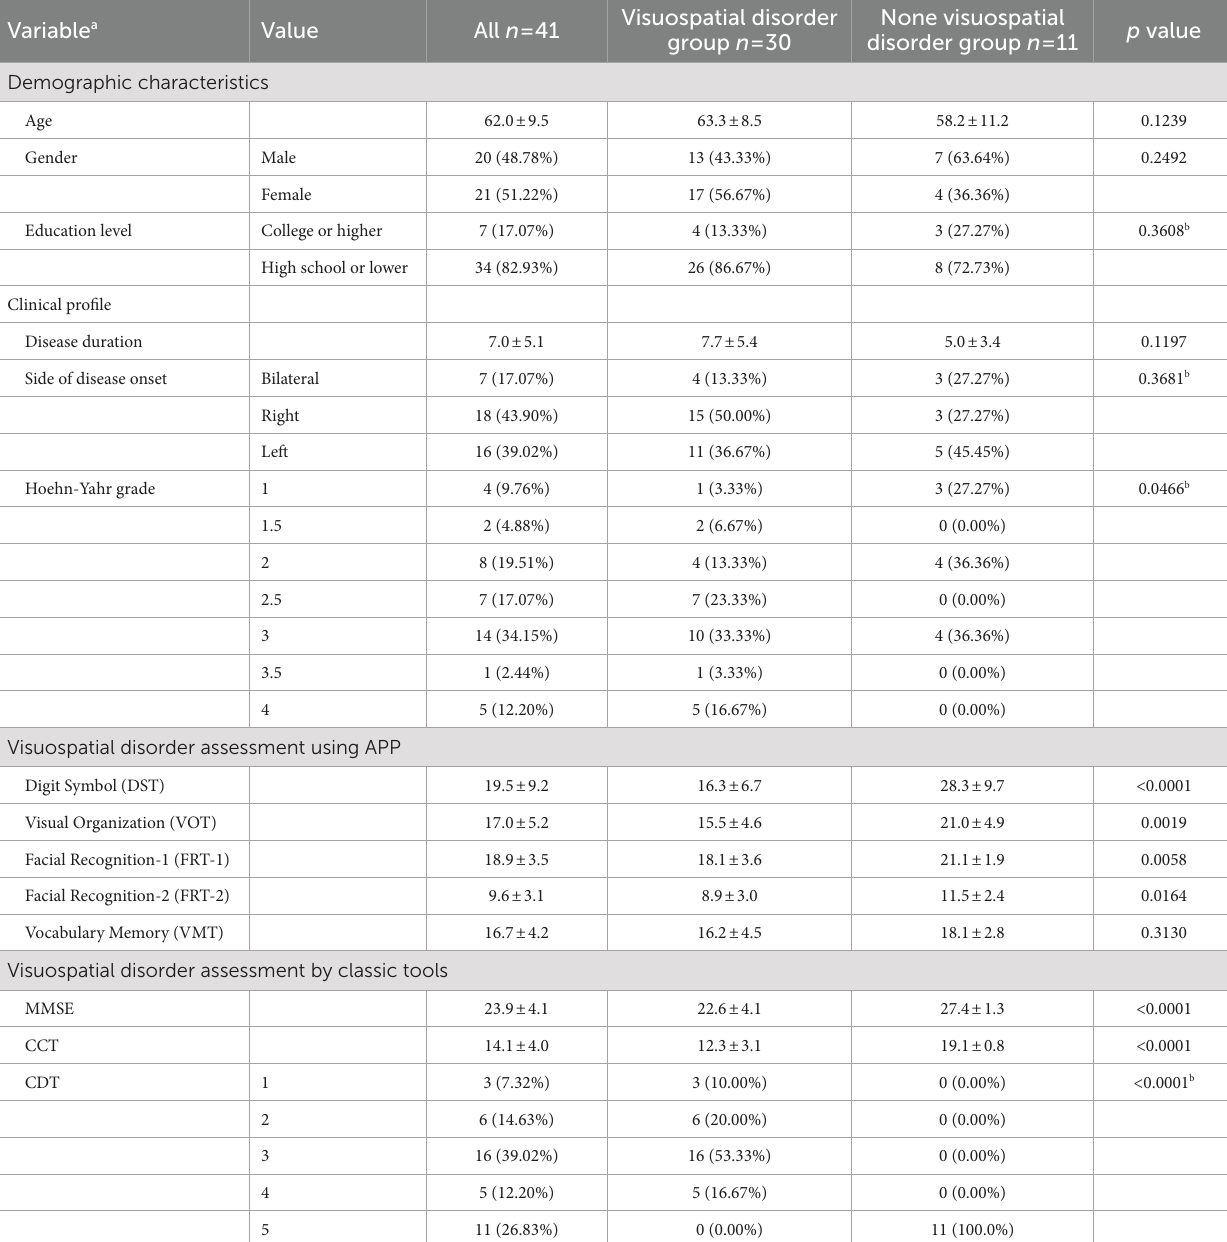
TABLE 1 Demographic, clinical, and visuospatial profile of patients with PD. Variable